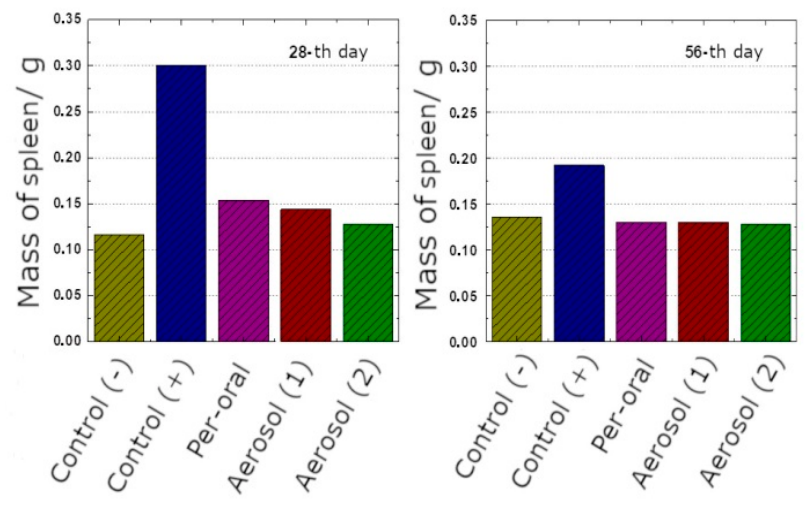
Figure 5. Spleen mass in the animals of experimental groups on the 28th and 56th days.